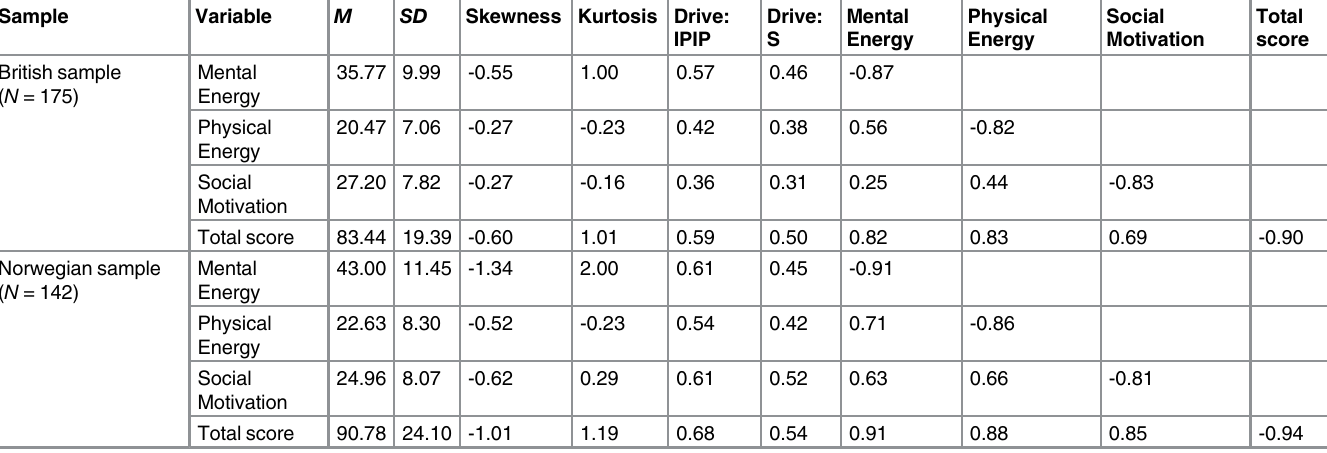
Table 7. Descriptive Statistics and Bivariate Correlations of the Drive:IPIP and Drive:S with MEI Scales in the British and Norwegian Samples.